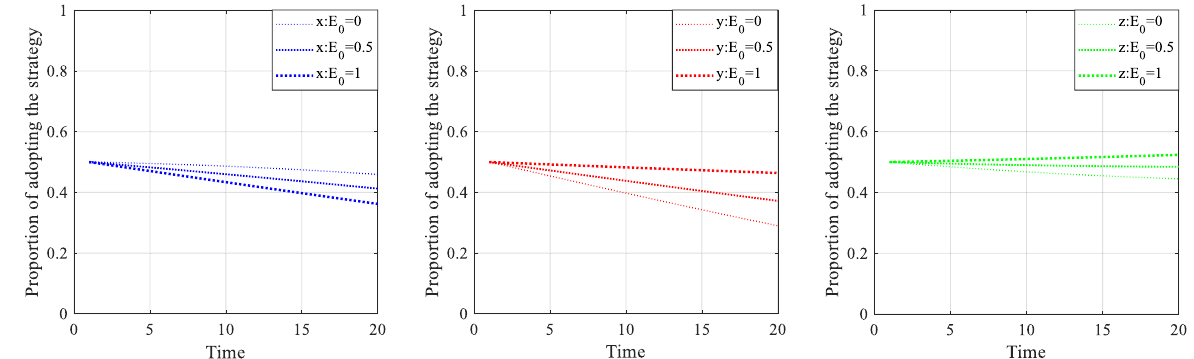
Figure 14. Evolution of strategies under different cost reference values E 0 .